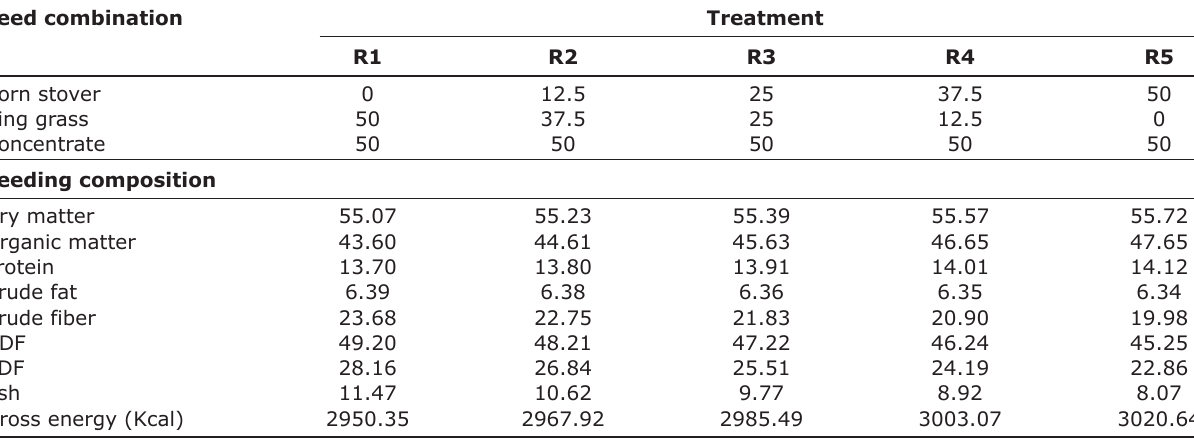
Table-2: Feeding formulation used in this study. Feed combination